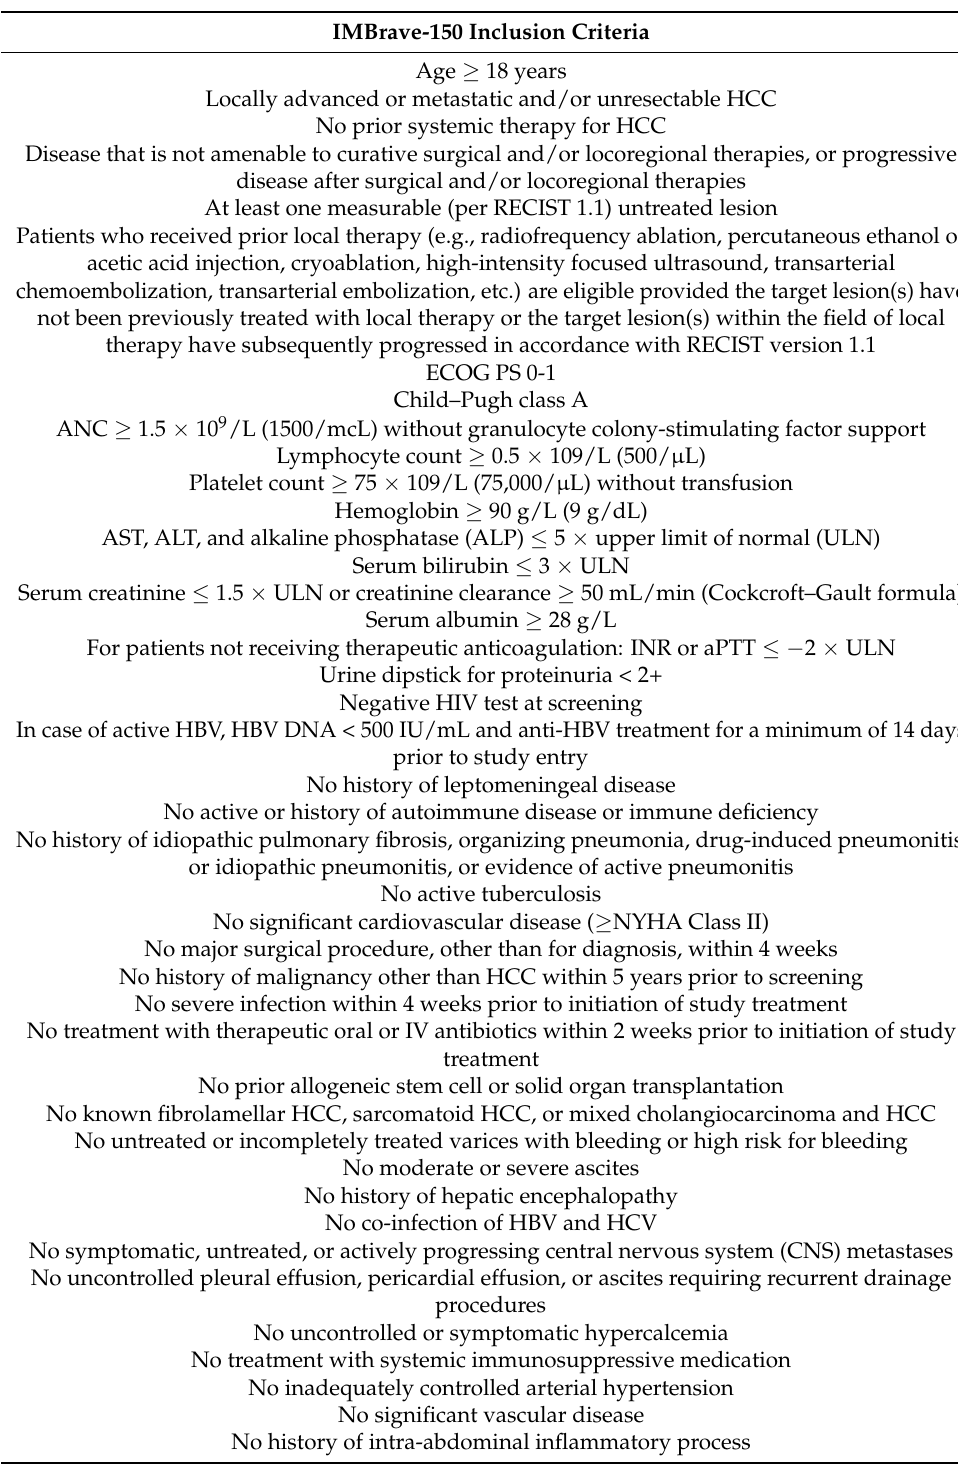
Table 2. Criteria of eligibility for the management of unresectable HCC with atezolizumab plus bevacizumab as a first-line